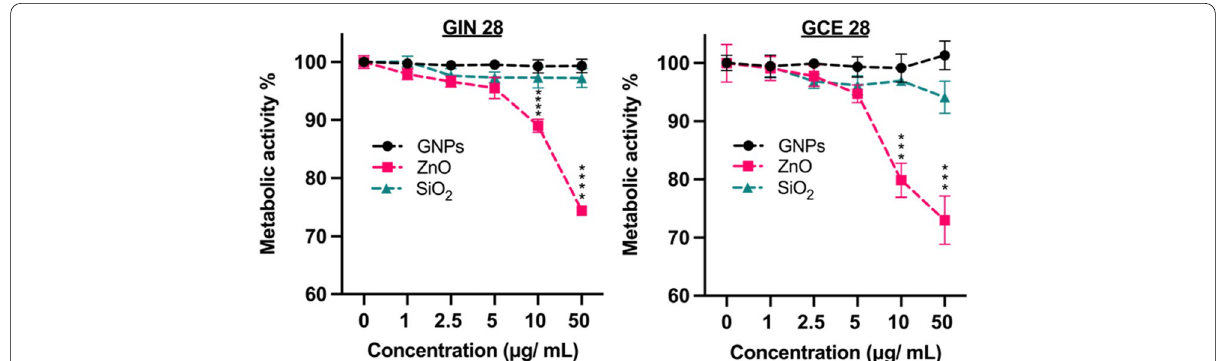
Fig. 2 In vitro toxicity of inorganic NPs on patient derived GBM cells. A GIN 28, and B GCE 28 were incubated with increasing concentration of GNPs, SiO 2 and ZnO NPs for 4 hours, before changing the media containing the NPs with fresh media. Metabolic activity was determined 48 hours after changing the media, the experiment was run in triplicate, and fluorescence at 590 nm is expressed as % of control (no NPs). Results are expressed as the mean S.D. * P < 0.05; ** P < 0.01; *** P < 0.001; and **** P < 0.0001 obtained using 2-way ANOVA with a Tukey ±